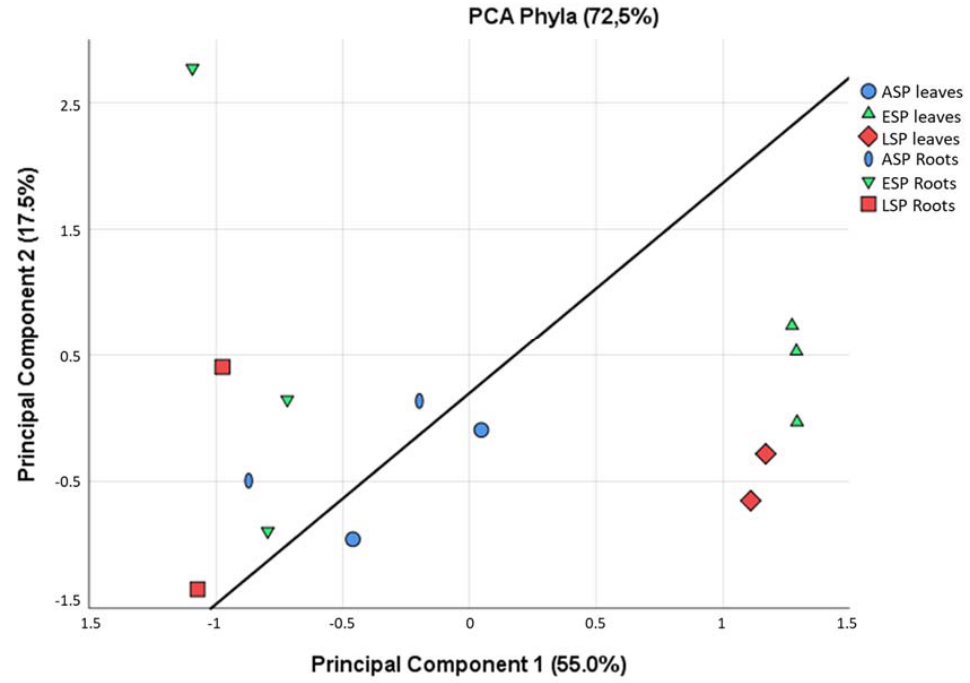
Figure 3. Principal Component Analysis calculated among all the samples, based on the relative abundance of OTUs in each phyla. The line was added to highlight the separation between leaves and roots.